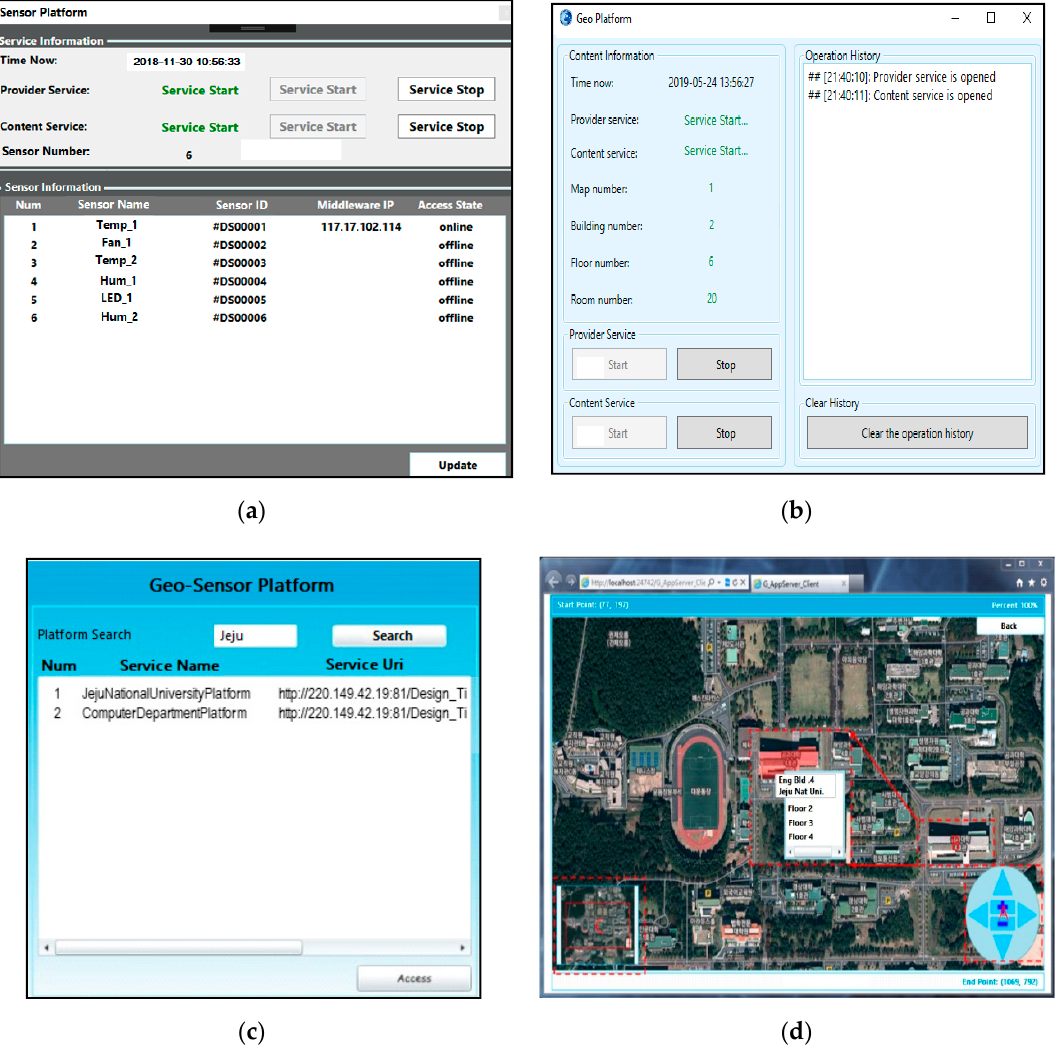
Figure 10. Geo-sensor platform service initiation deployed by the geo-sensor framework: ( a ) sensor platform sub-module; ( b ) geo platform sub-module; ( c ) geo-sensor platforms view; ( d ) selected geo-sensor platform.